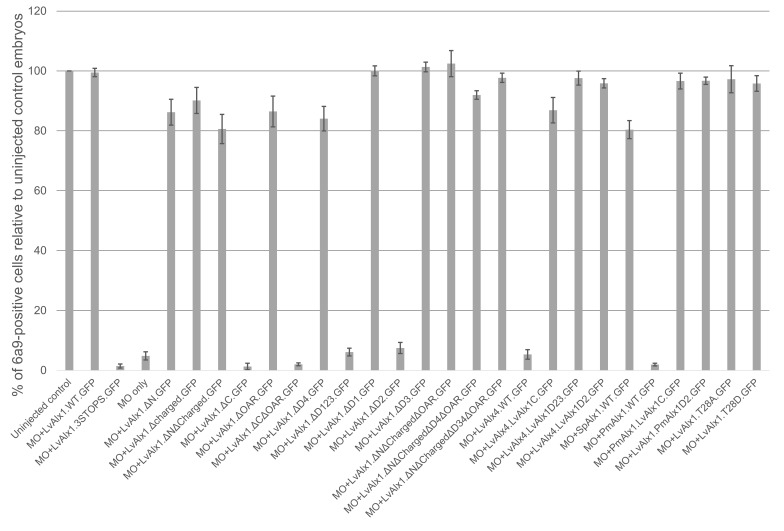
Quantitative analysis of MO rescue experiments.Each vertical bar indicates the mean percentage of 6a9-positive cells relative to uninjected control embryos, calculated from 80 to 100 embryos. Vertical lines represent standard errors. An average of 6a9-positive cells of control embryos of a given batch was first calculated. Subsequently, for each individual experimental embryo, a percentage of 6a9-positive cells relative to the average control value was calculated and the mean of those values was determined.